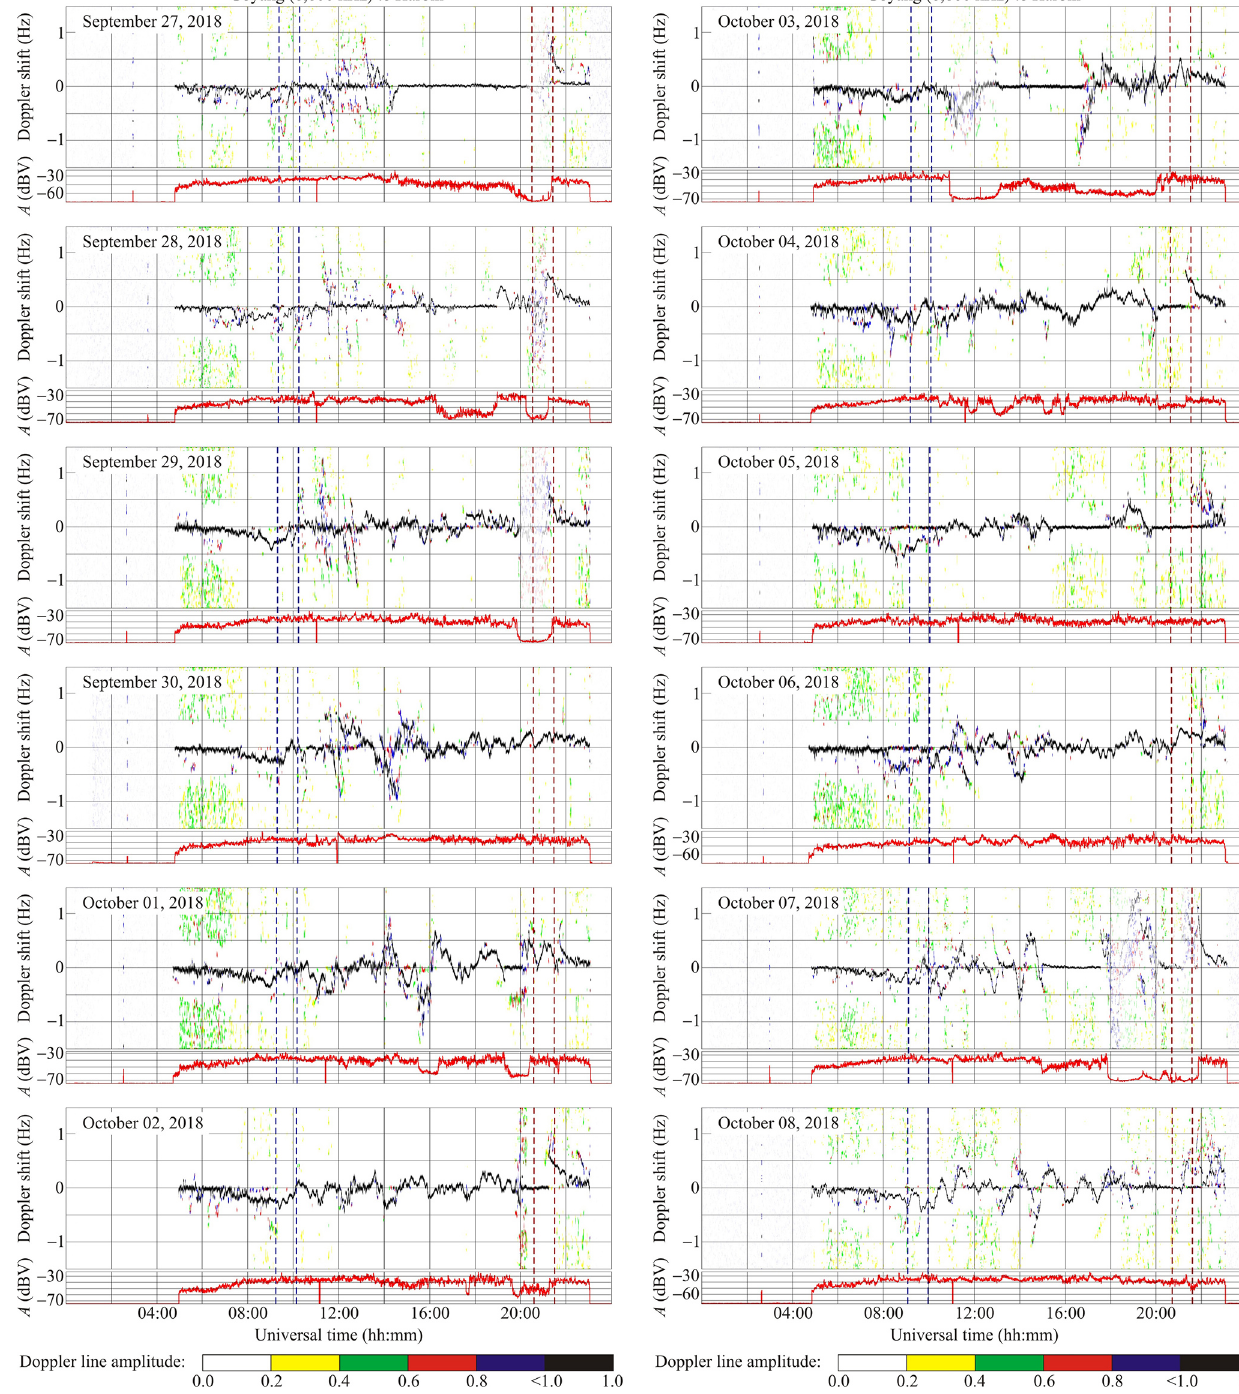
Figure 10. Same as in Fig. 6 but for the Goyang to Harbin radio-wave propagation path at 6600kHz for the 27 September–2 October and 3–8 October 2018